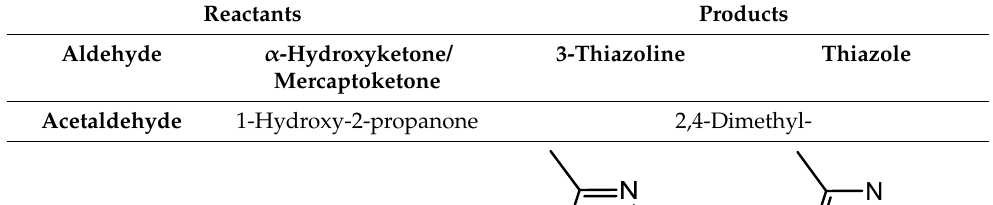
Table 4. Precursors for 3-thiazoline and thiazole synthesis.